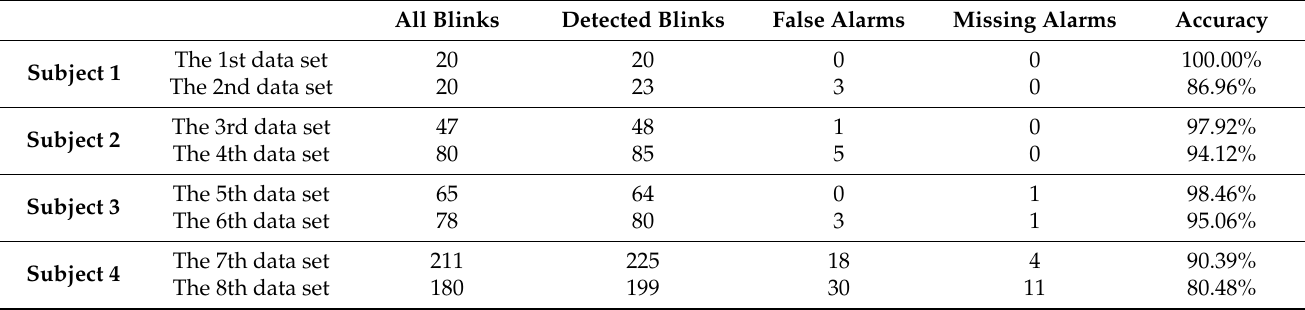
Table 3. Identification results of the blink artifacts in 8 MEG signal data